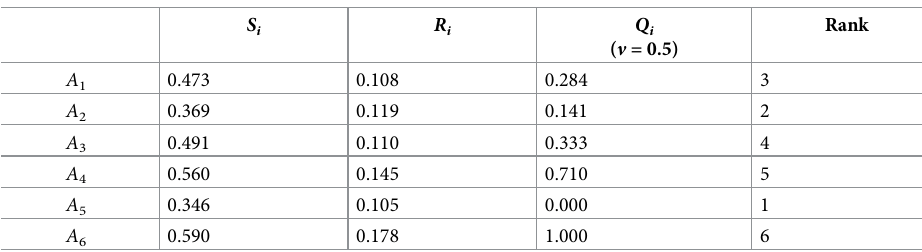
Table 14. Q values and